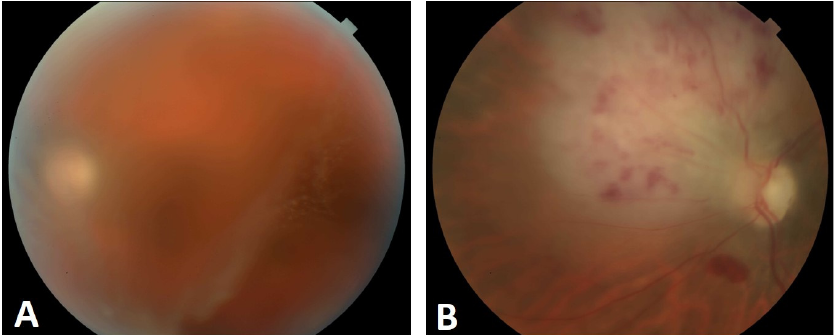
Figure 4. Fundus pictures, left eye; ( A ) showing vitritis before diagnostic vitrectomy; ( B ) showing infiltration of lymphoma cells into the retina causing a whitening of the retina nasally from optic nerve after vitreous biopsy.